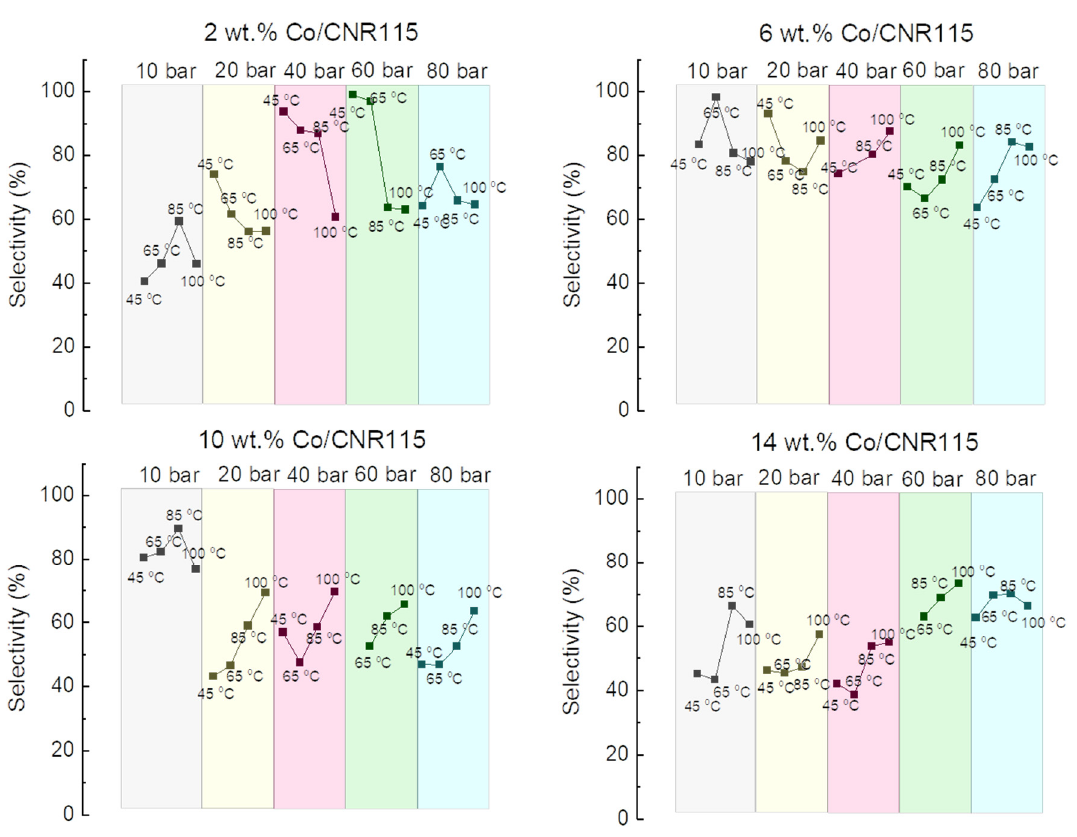
Figure 6. Selectivity towards 2-methylpentanal for 2, 6, 10 and 14 wt.% Co/CNR115 at different values of pressure and temperature.